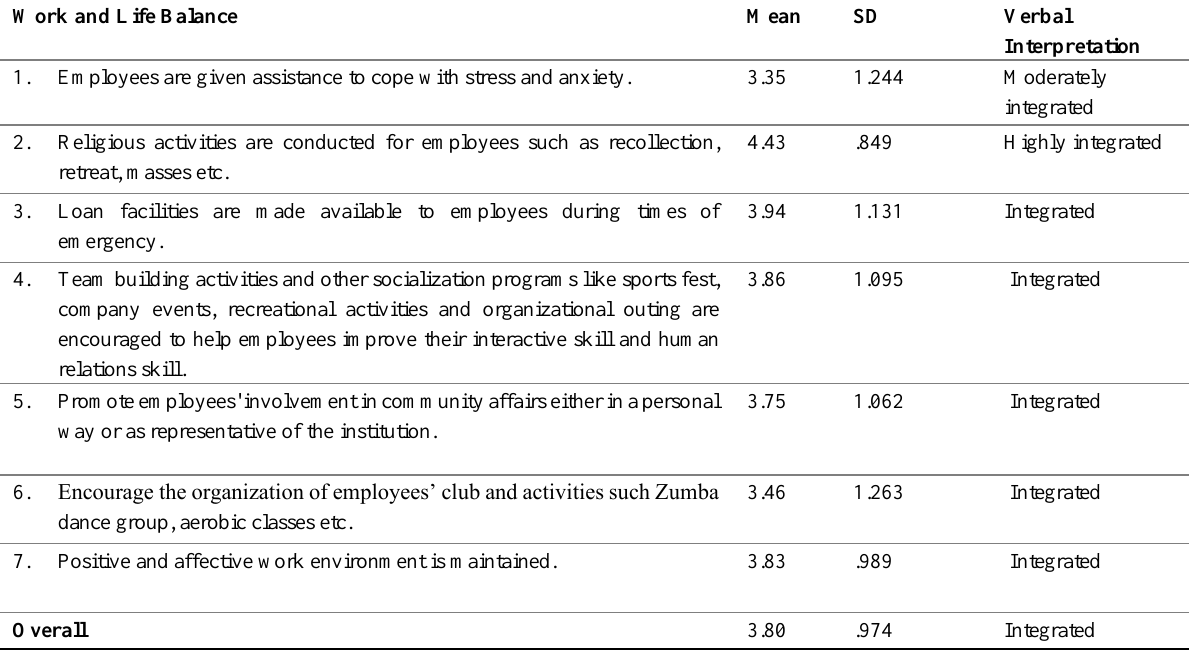
Table 5: Extent of Integration of Leadership to Work Life Balance as Perceived by Respondents Work and Life Balance Mean SD